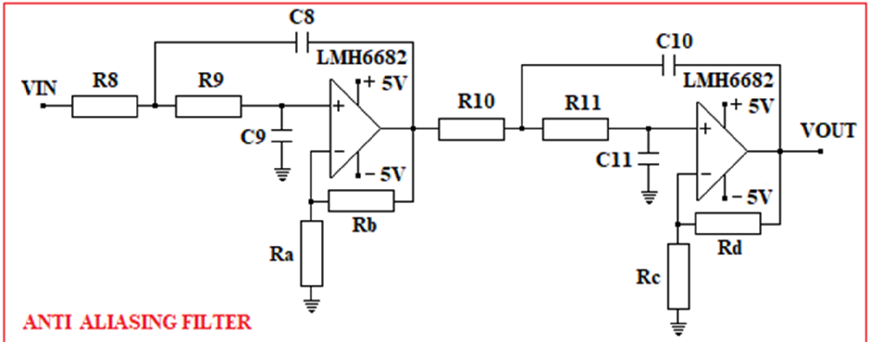
Figure 12. The Sallen–Key filter passes down in 2 steps.